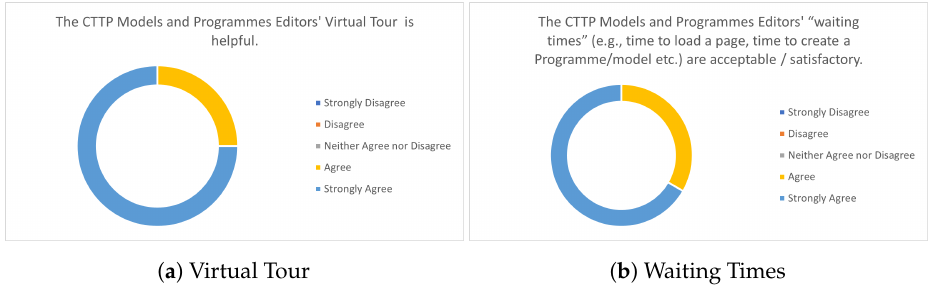
Figure 17. Participants response to the usefulness of the Virtual Tour feature ( a ) and level of accep- tance for the Editor’s waiting times ( b ).